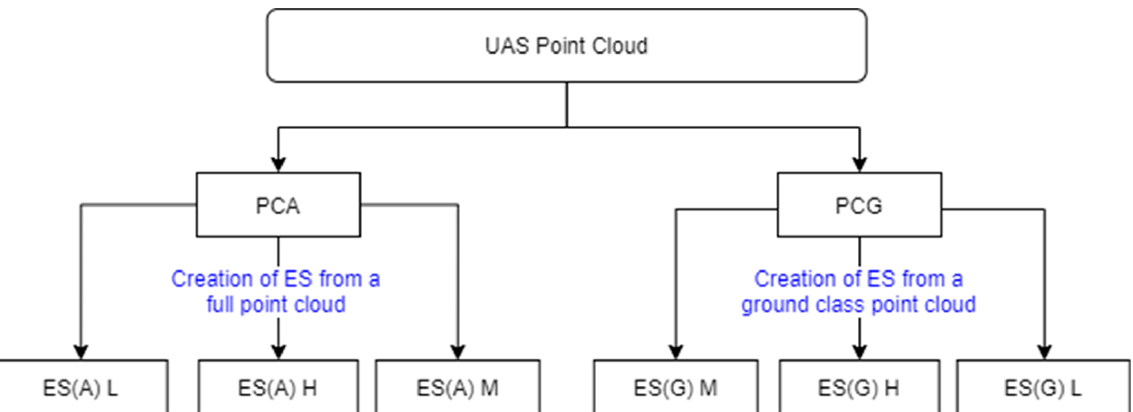
Figure 11. Creation of an ES surface based on the aggregation of values in the resulting raster cell based on the statistics M (mean value), H (highest value), and L (lowest value). Stage 2: Calculation of deviations from the BRS